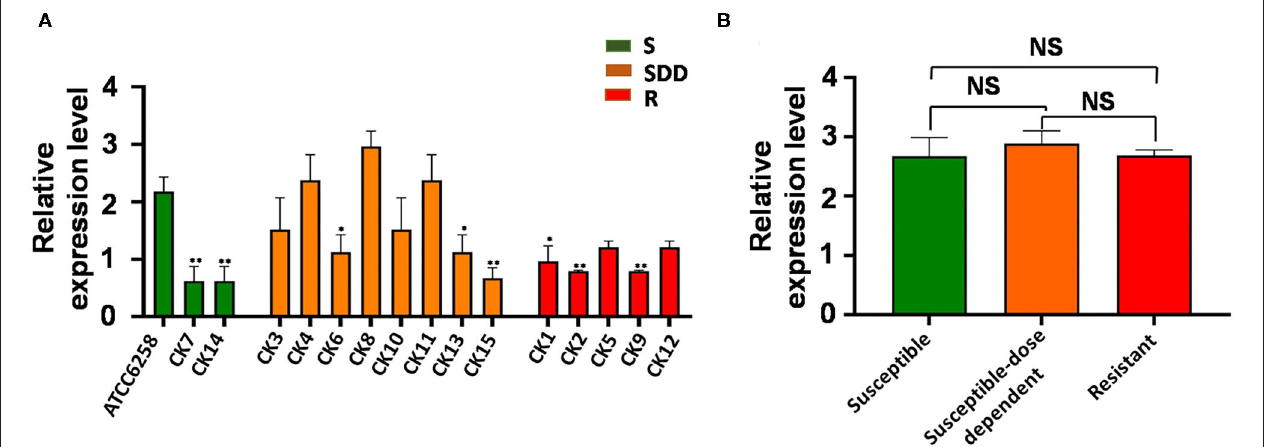
FIGURE 2 | ABC1 relative gene expression levels in three groups of C. krusei clinical isolates. (A) Relative levels of ABC1 mRNA in all the C. krusei clinical isolates. ABC1 gene expression levels were quantified and normalized relative to the reference gene, GAPDH; S, itraconazole-susceptible; SDD, itraconazole-susceptible dose dependent; R, itraconazole-resistant. Asterisks indicate that the difference between field isolates with the reference strain ATCC 6258 is significant compared to the reference strain ATCC 6258: * p < 0.05 in CK1, CK6, CK13 with ATCC6258 and ** p < 0.01 in CK2, CK7, CK9, CK14, CK15 with ATCC6258. (B) Log10 + 3 fold increase of gene expression levels in three groups (NS, no significance in SDD compared with S; * p < 0.05 in R with SDD; ** p < 0.01 in R with S).